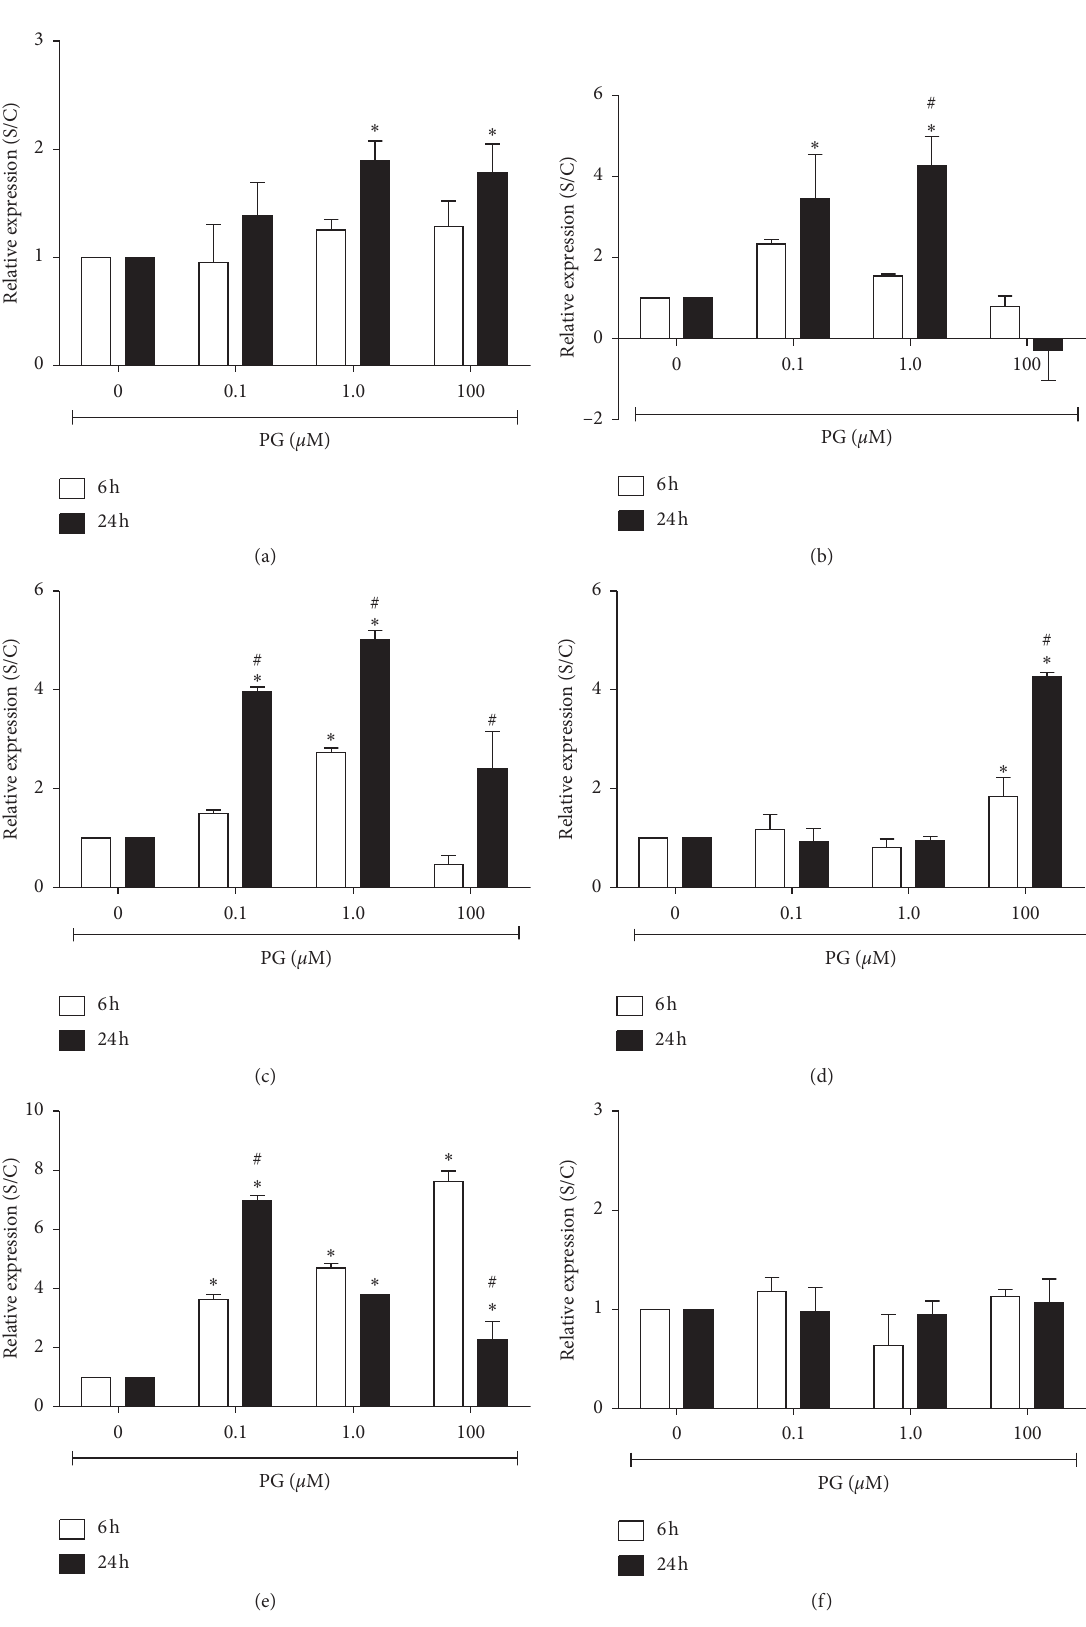
Figure 3: Relative expression of progesterone-regulated genes in RINm5F cells. Cells were incubated, for 6 or 24 h, with 0.1, 1.0, or 100 μ M progesterone. Data are presented as means ± SEM of three experiments in duplicates. (a) Scd1 ; (b) Duox1 ; (c) GPx6 ; (d) Hmox1 ; (e) Hspa1a ; (f) Prdx4 . S/C: expression in the progesterone-treated cultures in comparison to control. ∗ indicates difference compared to control. # indicates difference between the time points, for the same progesterone concentration ( ρ < 0.05). PG: